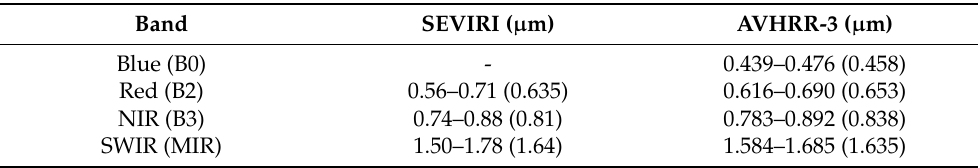
Table 3. MSG/SEVIRI and Metop/AVHRR-3 spectral bands, full width at half maximum and centre wavelength in